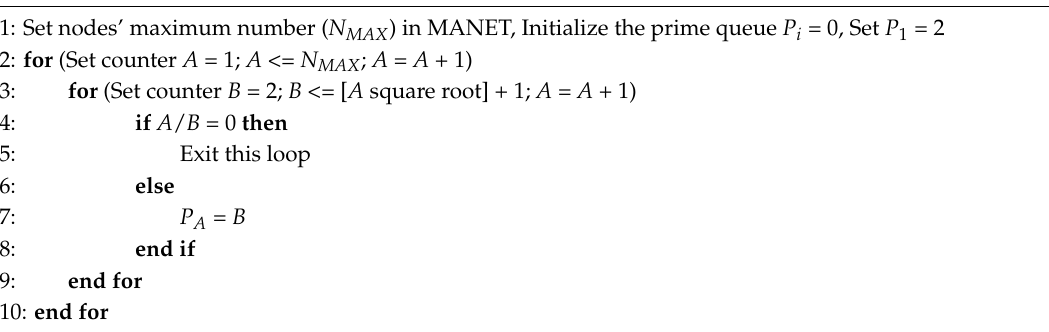
Algorithm 1. Prime queue generation